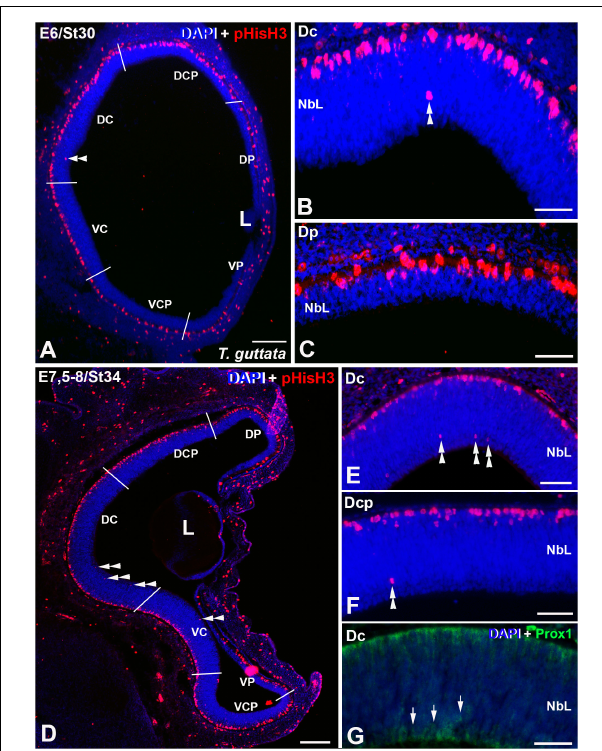
FIGURE 4 | Expression patterns of pHisH3 (A–D) , Prox1 (E) , and Isl1 (F,G) in retinal cryosections of T. guttata at E8-9 (St39). Cryosections were counterstained with DAPI. (A–D) Non-apical mitoses were mainly detected in Dp, Vc, and Vcp sectors [double arrowheads in panels (A–C) ]. (E) Retinal lamination was almost complete in the Dc sector and Prox1 immunoreactivity was mainly restricted to the region of the presumptive horizontal cell layer (arrowheads). Sparse Prox1-immunoreactive nuclei were detected in more internal regions (double arrowheads). (F,G) Isl1-immunoreactive migrating neuroblasts were dispersed throughout the NbL (double arrowheads). Isl1-immunoreactive presumptive horizontal cells were detected in the Vc region [arrowheads in panel (F) ]. Abbreviations: GCL, ganglion cell layer; IPL, inner plexiform layer; NbL, Neuroblastic layer. Scale bars: 50 µ m.